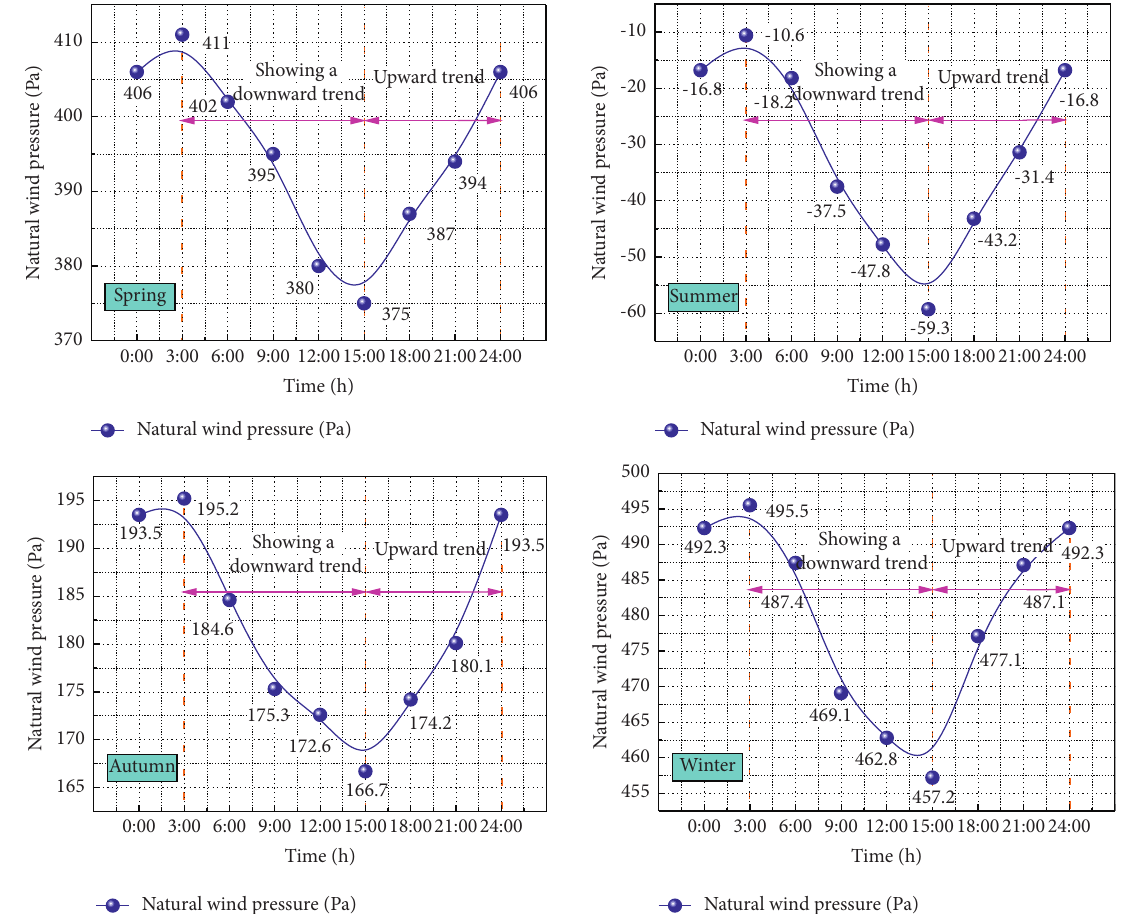
Figure 5: Changes in natural wind pressure on one representative day in each of the four